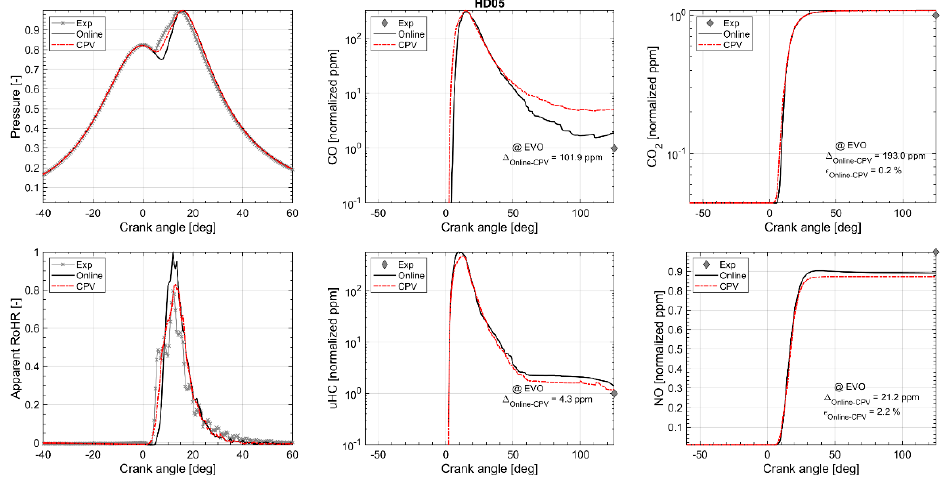
Figure A5. Engine performance and emissions for operating point HD05 (1200 rpm, 6.0 bar IMEP).